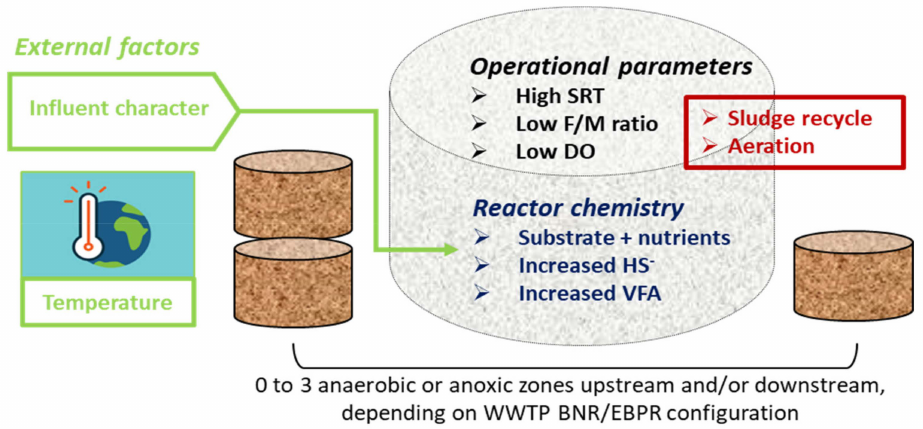
Figure 2. Schematic showing (i) the relationships between the main factors that play roles in fila- mentous bulking (external factors shown in green , aerobic reactor chemical parameters shown in blue , and operational parameters shown in black ), and (ii) means of controlling some of these factors (in red ). SRT—sludge retention time; F/M—food-to-microorganism ratio; DO—dissolved oxygen; HS—hydrogen sulphide; VFA—volatile fatty